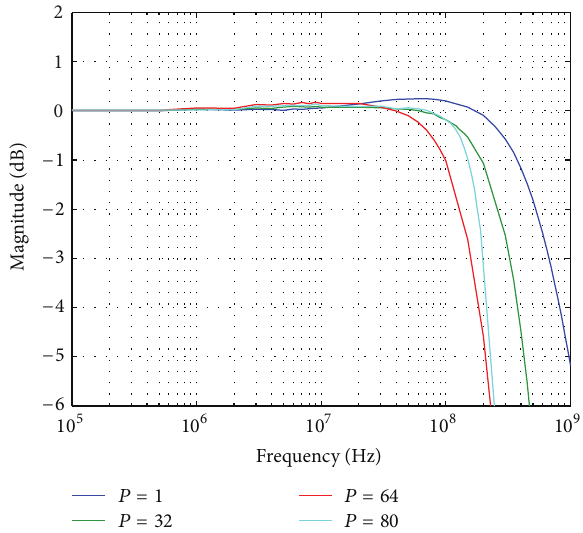
Figure 17: Frequency response of the serial and low-latency parallel